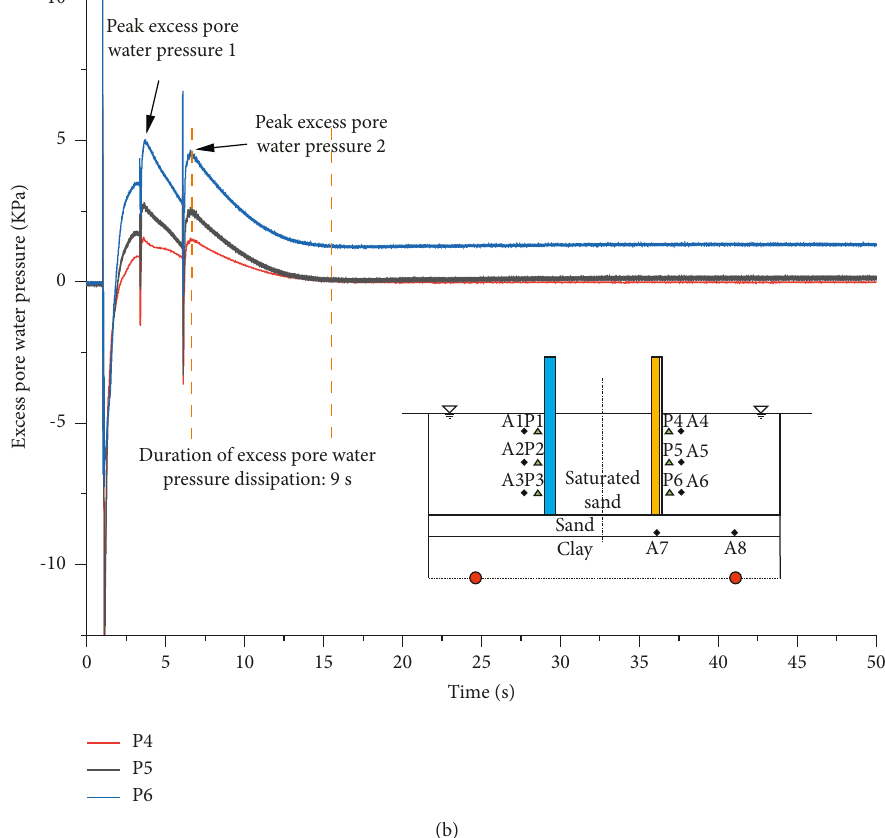
Figure 18: (a) Time course curve of excess pore water pressure in sand on one side of the ordinary pile. (b) Time course curve of excess pore water pressure in sand on one side of the drainage rigid